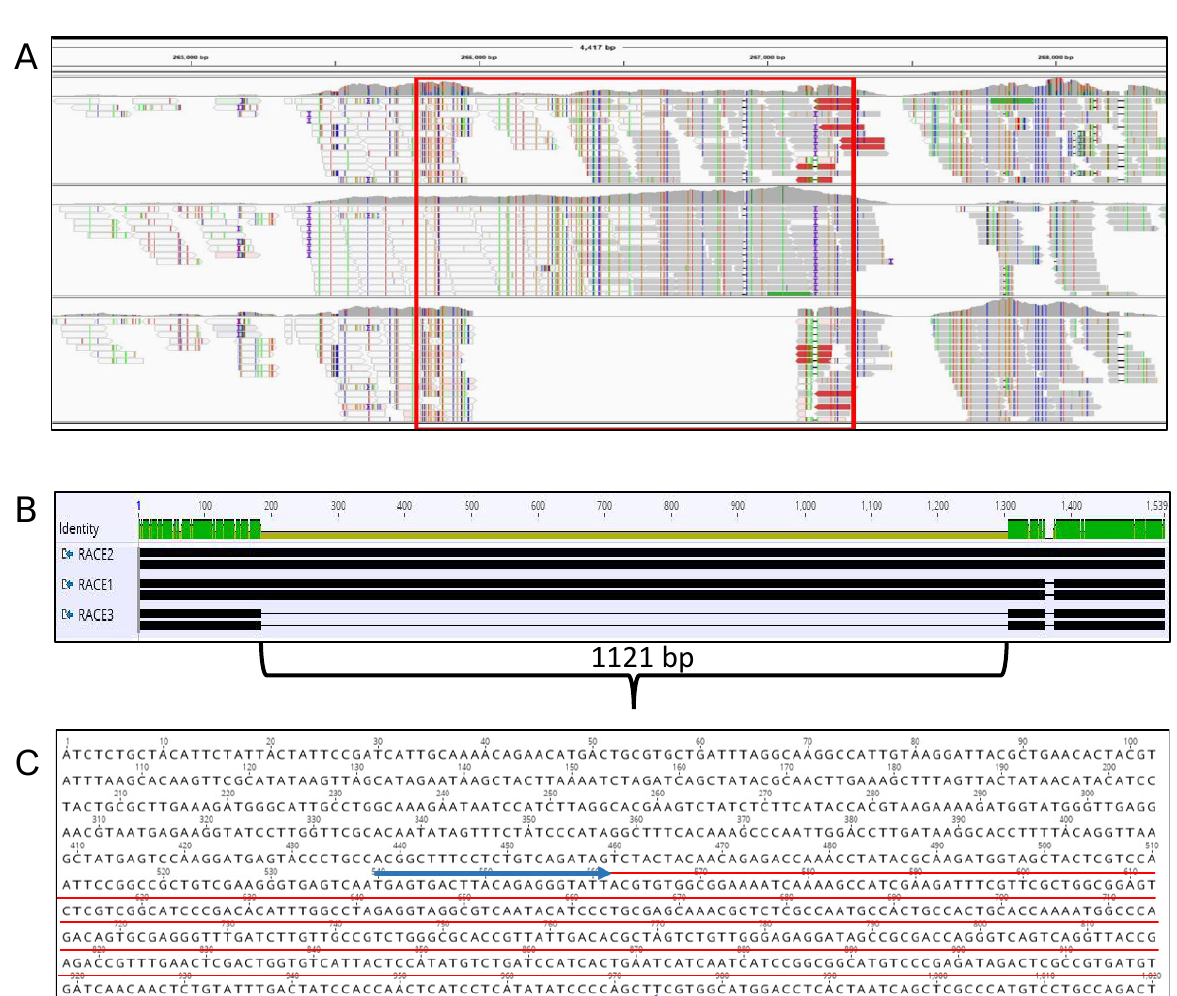
Figure 1. Region targeted for Polymerase Chain Reaction (PCR) amplification on chromosome 14 of Fusarium oxysporum f. sp. niveum (FON). ( A ) Interactive Genomics Viewer (IGV) window of races 1, 2, and 3. Red box indicates the area investigated for amplification. ( B ) Geneious alignment of races 1, 2, and 3, zoomed in on a 1540 bp section showing 1121-bp absent in race 3. ( C ) 1121 bp sequence on Geneious. Amplified sequence is underlined in red, forward and reverse primers are underlined in blue.